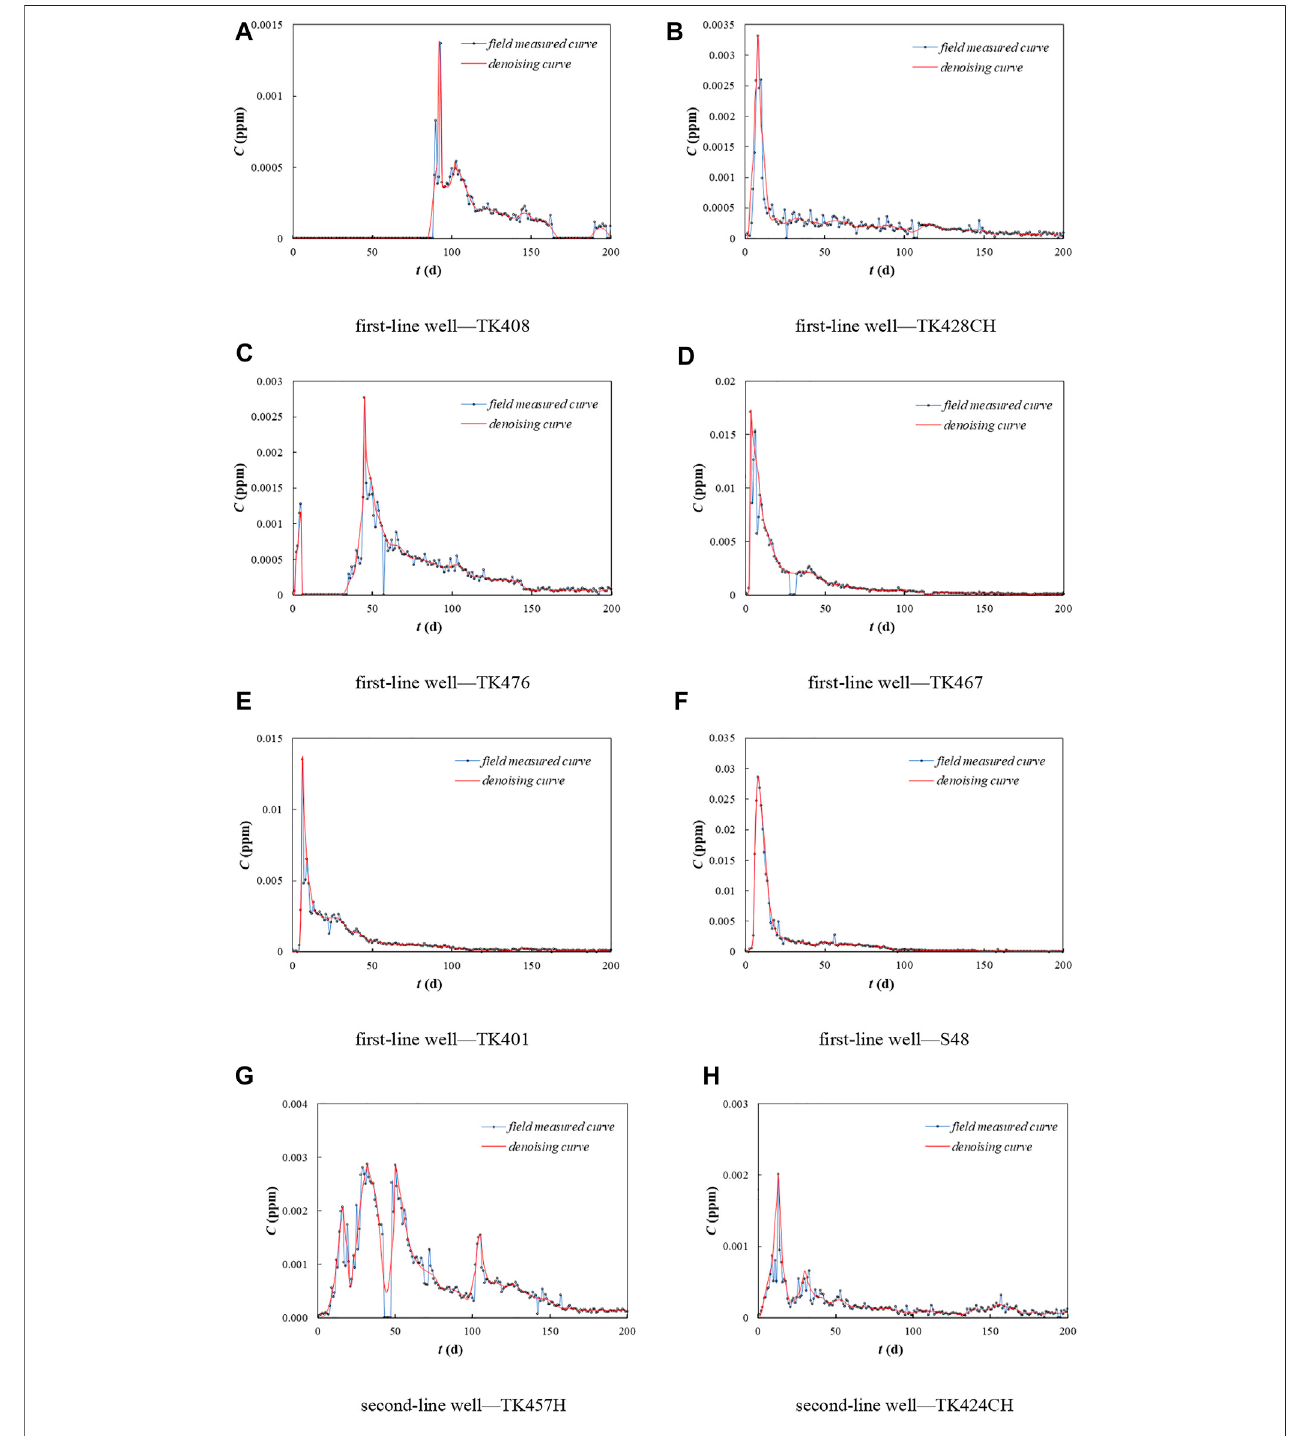
FIGURE 17 | Tracer output concentration curves and denoising curves for TK411 well group. (A) fi rst-line well — TK408 (B) fi rst-line well — TK428CH (C) fi rst-line well — TK476 (D) fi rst-line well — TK467 (E) fi rst-line well — TK401 (F) fi rst-line well — S48 (G) second-line well — TK457H (H) second-line well — TK424CH.